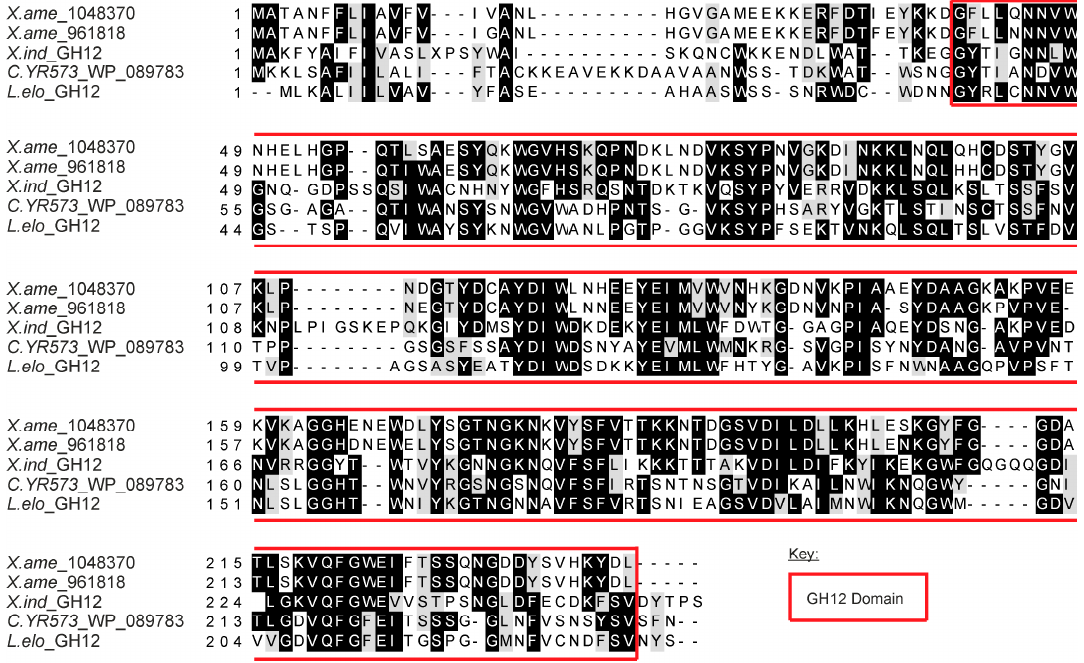
Figure 1. Alignment of amino acid sequences of GH12s identified from X. index and L. elongatus RNA sequencing (RNAseq), the two GH12 sequences identified from the X. americanum genome, and the most closely related sequence in non-redundant (nr). The GH12 domain is highlighted by a red box, and covers the majority of the protein sequence.